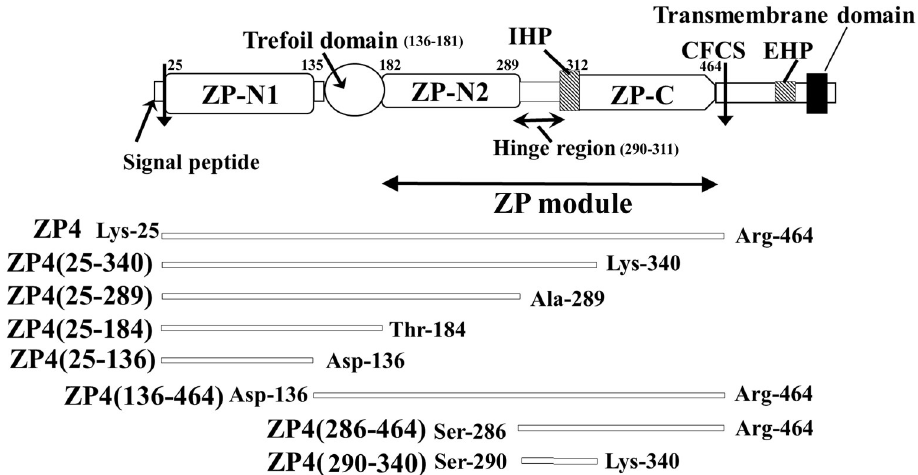
Fig 1. Schematic representation of the bovine zona pellucida (ZP) 4 polypeptide precursor and the recombinant ZP4 mutants examined in this study. The bovine ZP4 precursor is synthesized as a transmembrane protein consisting of a signal peptide, the N-terminal ZP-N-like domain (ZP-N1), the trefoil domain, the N-terminal half domain of the ZP module (ZP-N2), the flexible hinge region, an internal hydrophobic patch (IHP) in the C-terminal half domain of the ZP module (ZP-C), a consensus furin cleavage site (CFCS), an external hydrophobic patch (EHP), and a transmembrane domain. The mature ZP4 polypeptide includes Lys-25 to Arg-464. The ZP4 fragments examined in this study are shown by open bars. Translation initiation Met is numbered as